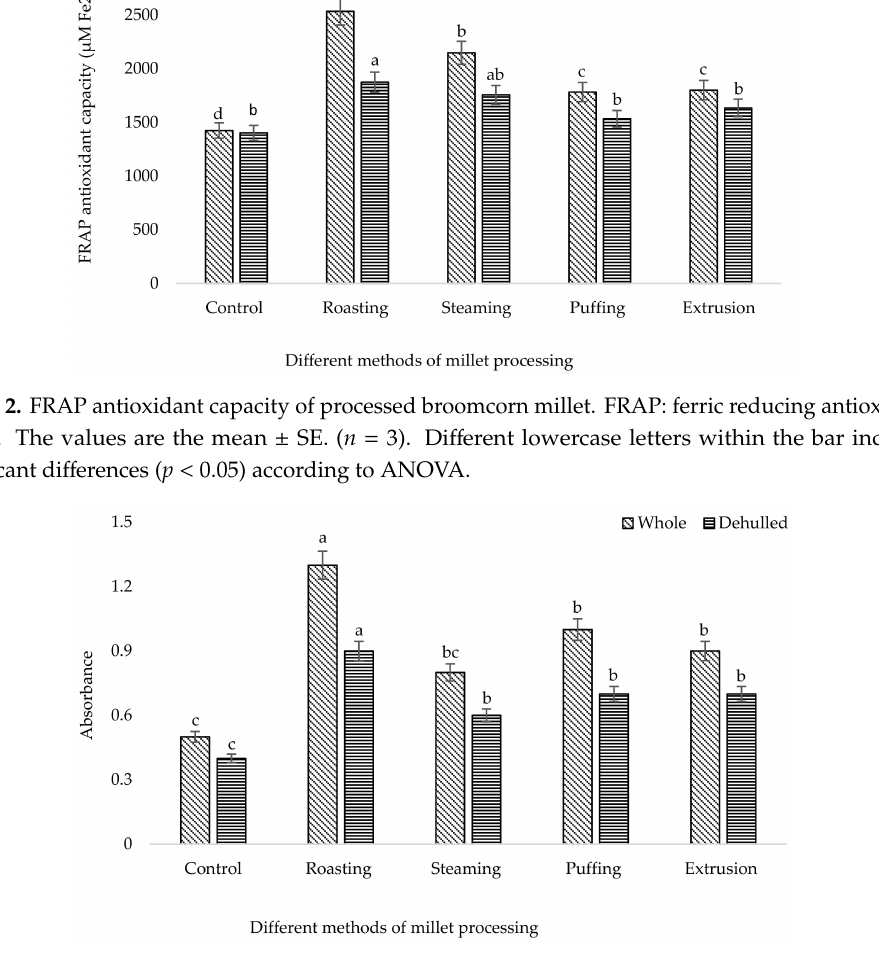
Figure 3. Total antioxidant capacity of processed broomcorn millet. The values are the mean ± SE. ( n = 3). Different lowercase letters within the bar indicate significant differences ( p < 0.05) according to ANOVA.